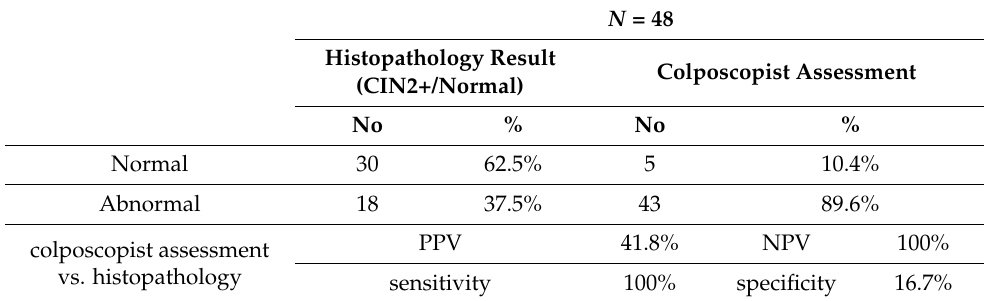
Table 3. Histopathological assessment of the biopsy samples compared to the expert colposcopist